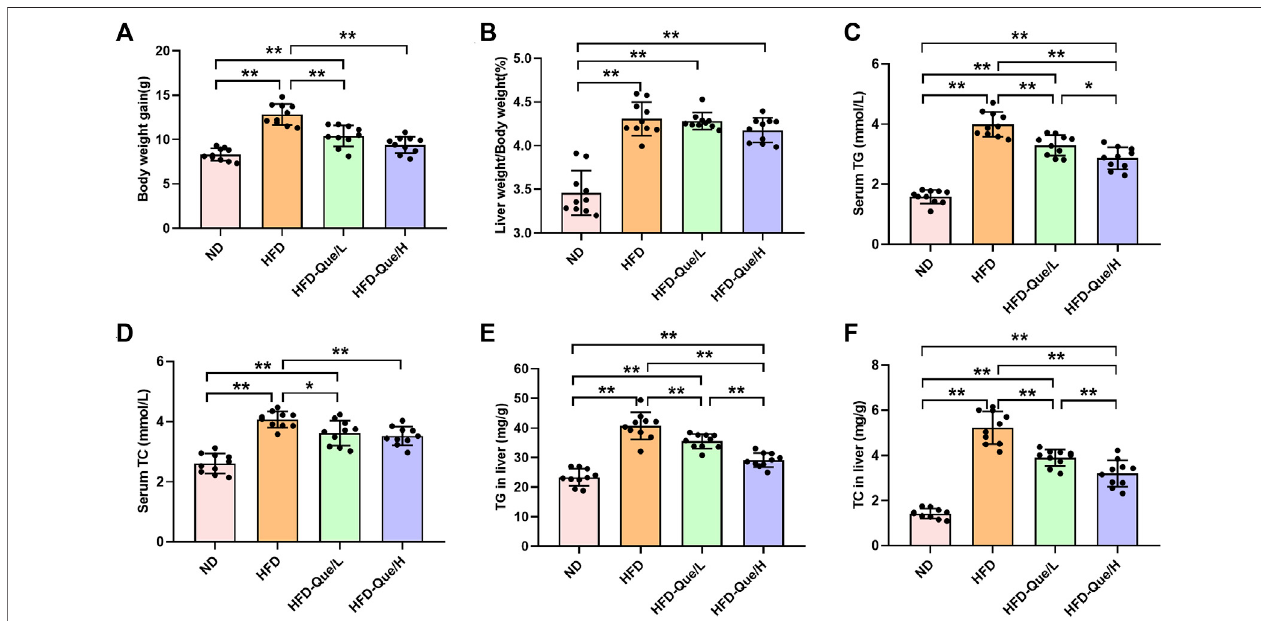
FIGURE1| QuealleviatedlipidmetabolismparametersinHFD-fedmice( n =10). (A) Bodyweightgain. (B) Liverweight/Bodyweight. (C) SerumTG. (D) SerumTC. (E) TG in the liver. (F) TC in the liver. The data are expressed as the mean ± SD. **, p < 0.01 and *, p <